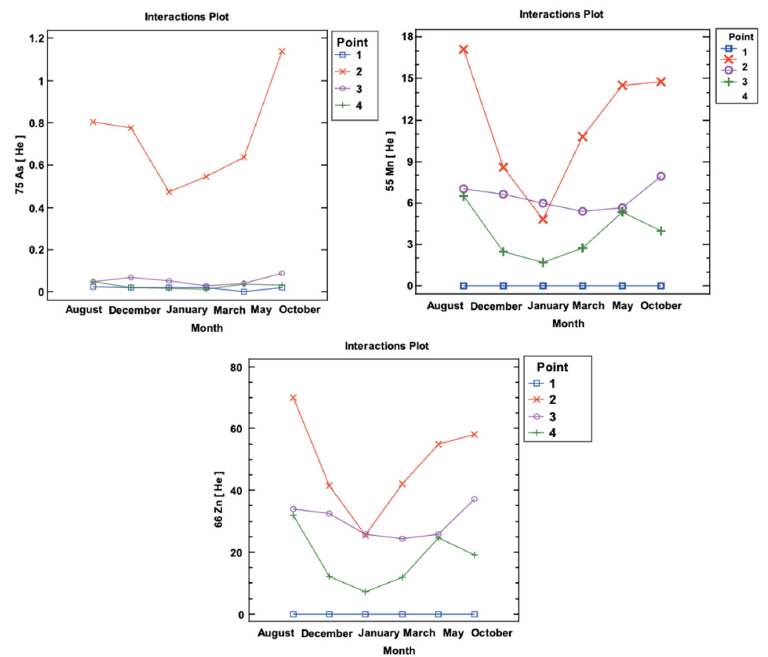
Figure 5. Graph of interactions between the month and the sampling point for the concentration of heavy metals.